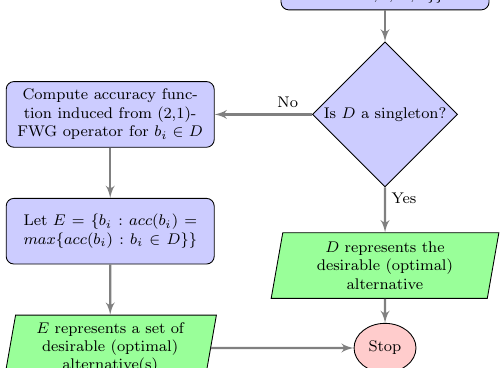
compute the score function for each candidate. If there are some candidates who have the same score function, then we compute their accuracy function to decide who is the optimal candidate(s); see, Table